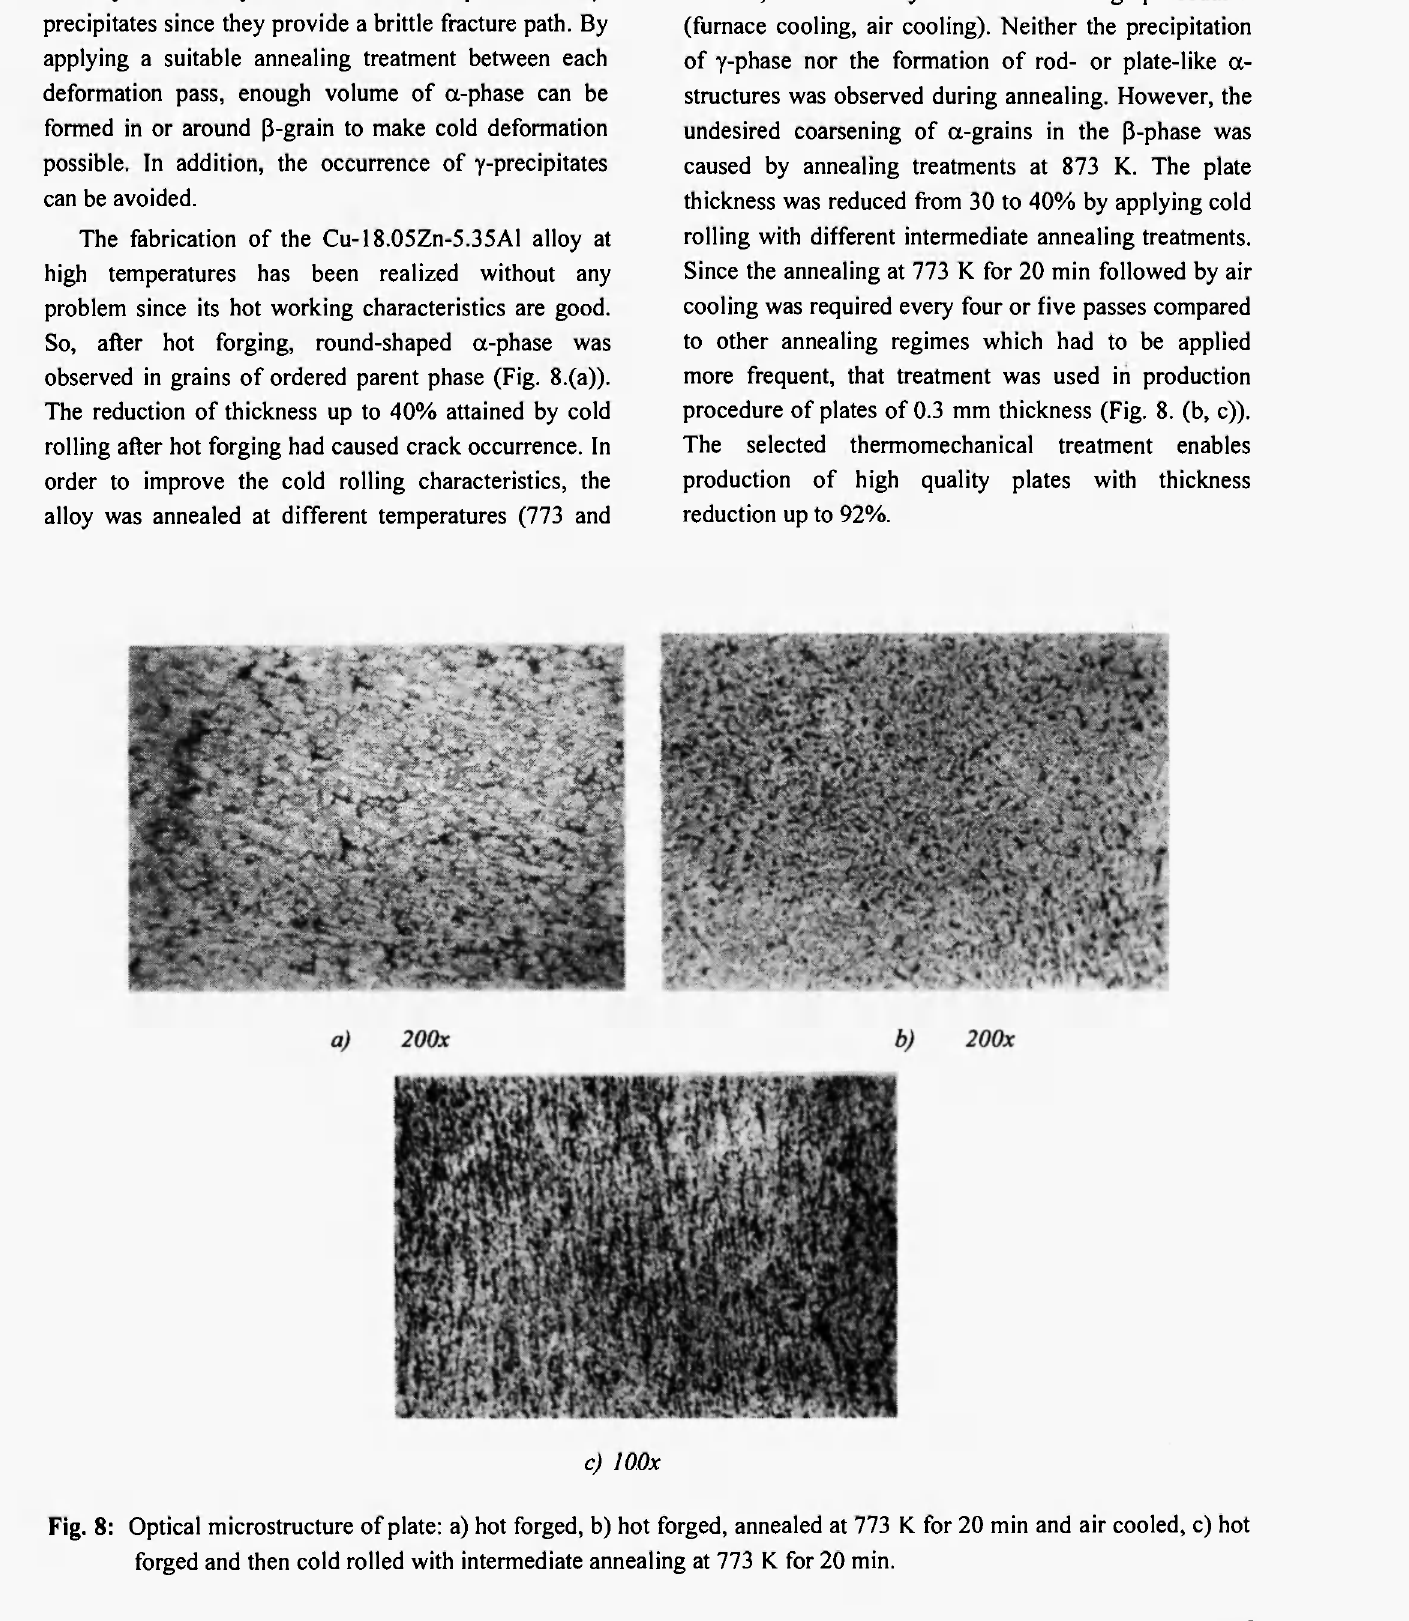
Fig. 8: Optical microstructure of plate: a) hot forged, b) hot forged, annealed at 773 Κ for 20 min and air cooled, c) hot forged and then cold rolled with intermediate annealing at 773 Κ for 20